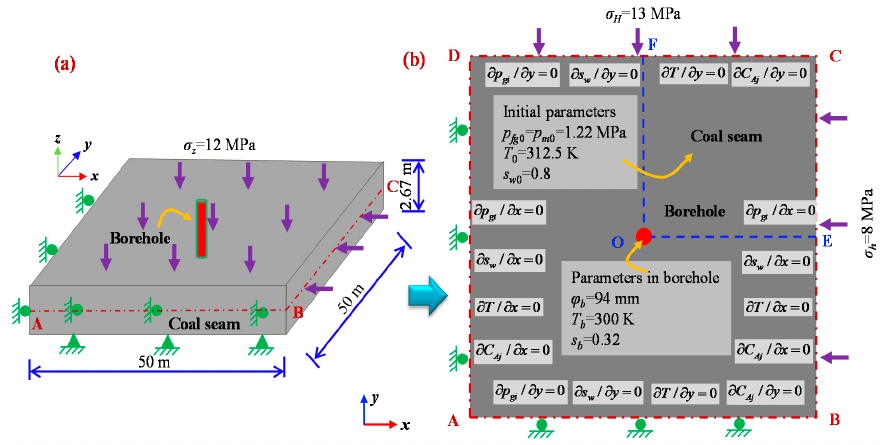
Figure 5. Geometry model and boundary setting for simulating acid fracturing in coal seam, ( a ) the 3D geometry of coal seam, ( b ) the simplified 2D geometry for simulation. Table 1. Related parameters for numerical simulation of AF-ECBM recovery.